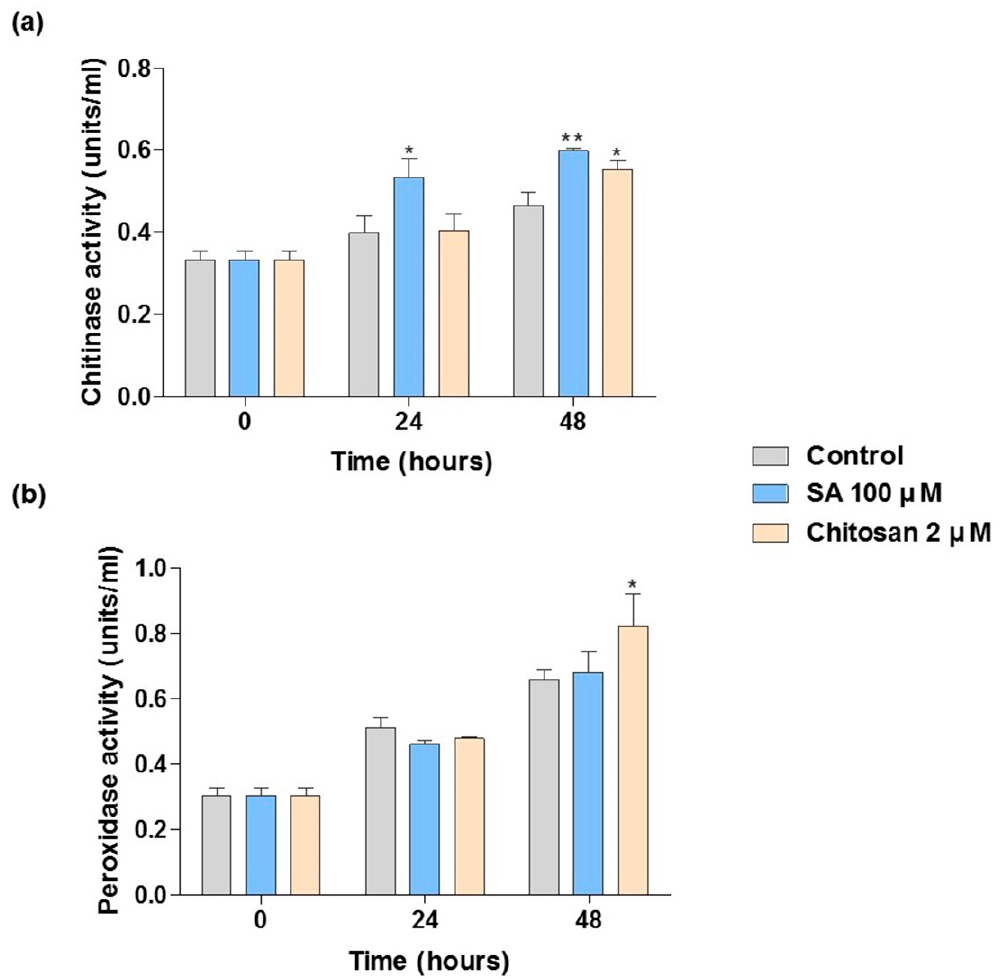
Figure 5. Chitinase and peroxidase activity of detached Keumkang wheat leaves treated with SA or chitosan. ( a ) Chitinase and ( b ) peroxidase activity in detached Keumkang wheat leaves of 14-days-old seedlings grown on the BAP media containing SA or chitosan after inoculation with leaf rust were measured at 0, 24, and 48 h. Error bars represent standard deviation ( n = 3). Asterisks indicate significant differences compared to control each time. Data were statistically analyzed by a Student’s t-test (*: p < 0.05, **: p < 0.01).